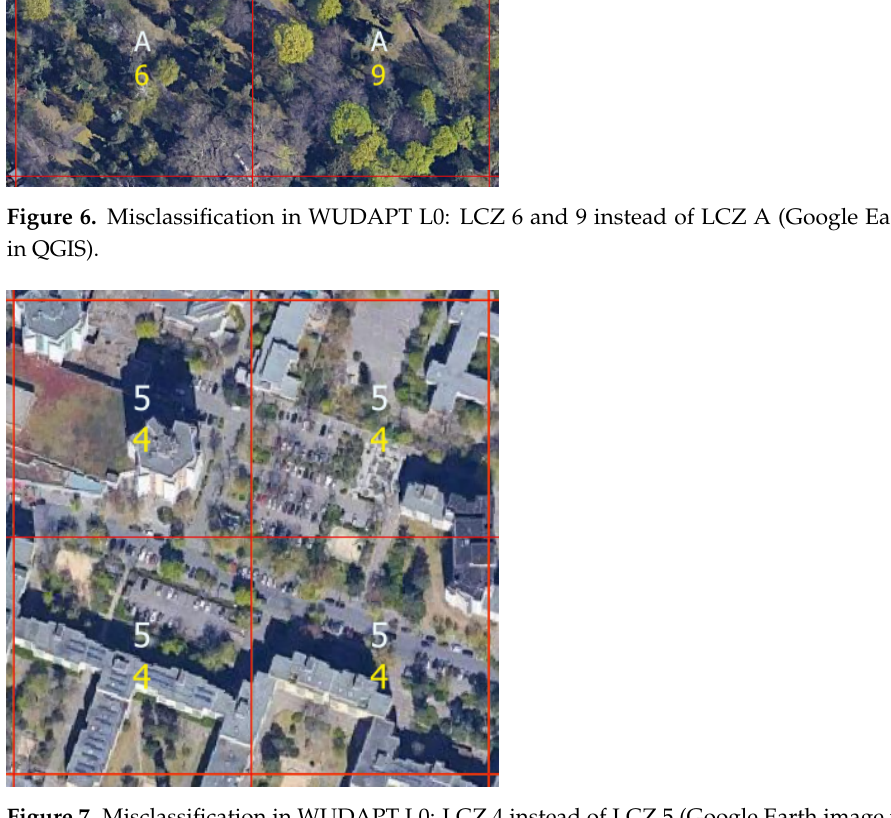
Figure 7. Misclassification in WUDAPT L0: LCZ 4 instead of LCZ 5 (Google Earth image in